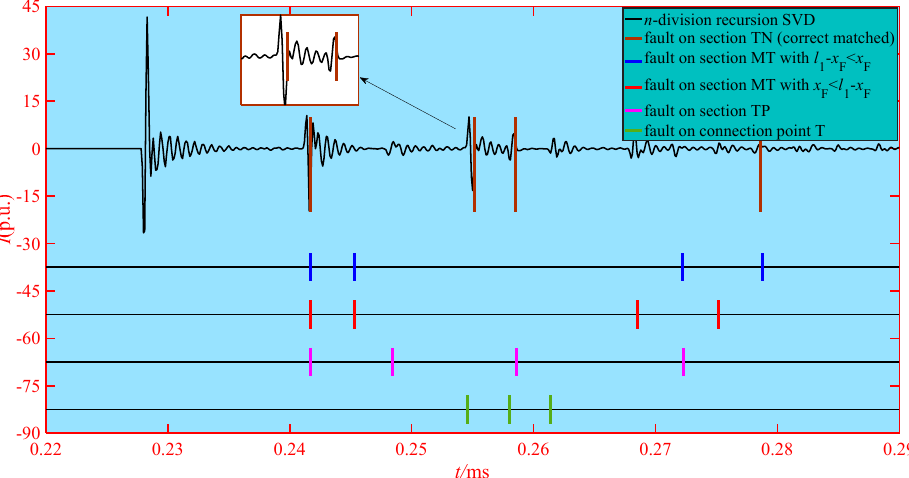
Figure 13. Full-line matching algorithm for section l 3 fault and matching results with n -division recursion SVD.